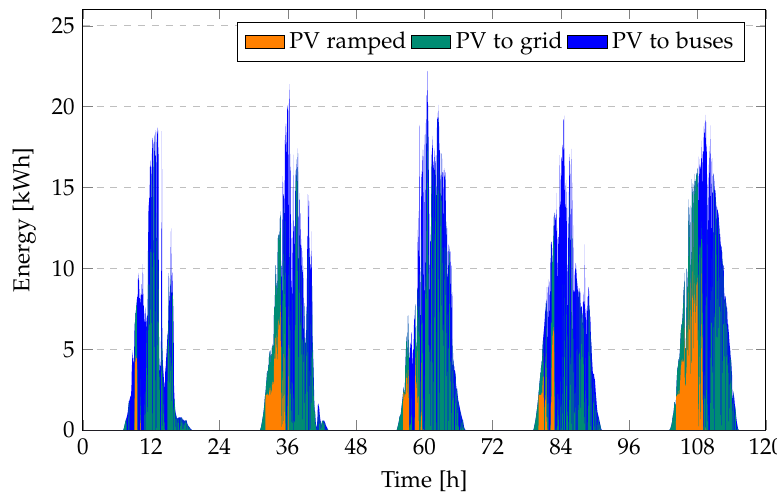
Figure 10. PV generation, PV 2 Bus, ramped energy, and energy fed to the grid at 10% ramp rate limit for the bus operator’s objective (Equation (17)) over a period of five days.